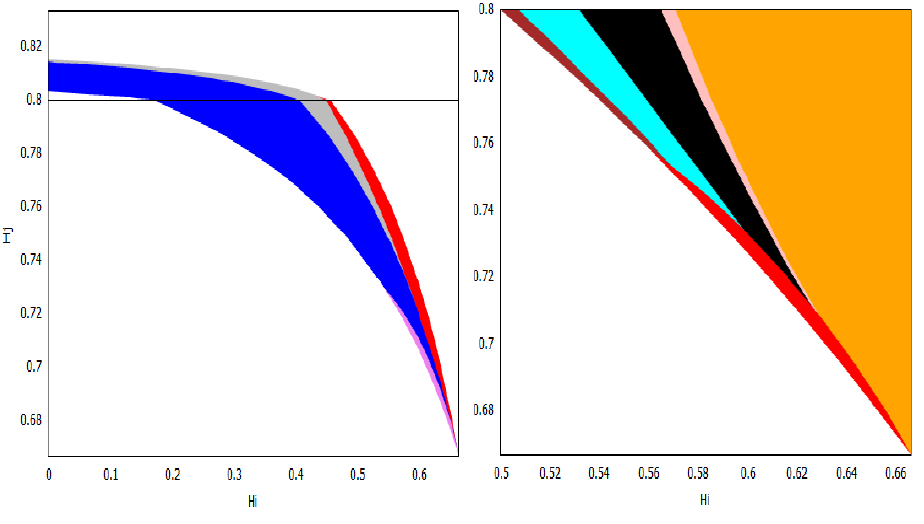
Figure 9. Left : The decomposition of the PD region according to the violet, blue and grey regions; Right : In red, the portion of the brown, cyan, black, pink and orange regions that intersects the PD